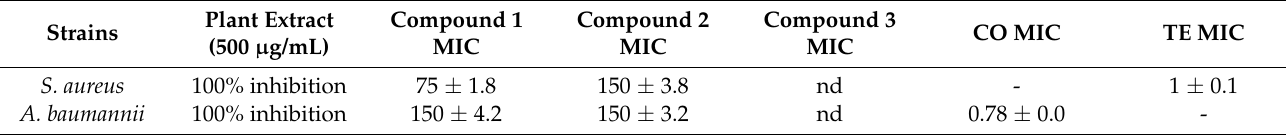
Table 1. Antibacterial activity of the leaves extract, expressed as a percentage of growth inhibition, and of compounds 1 – 3 , expressed as MIC ( µ g/mL) ± standard deviation (SD), against test